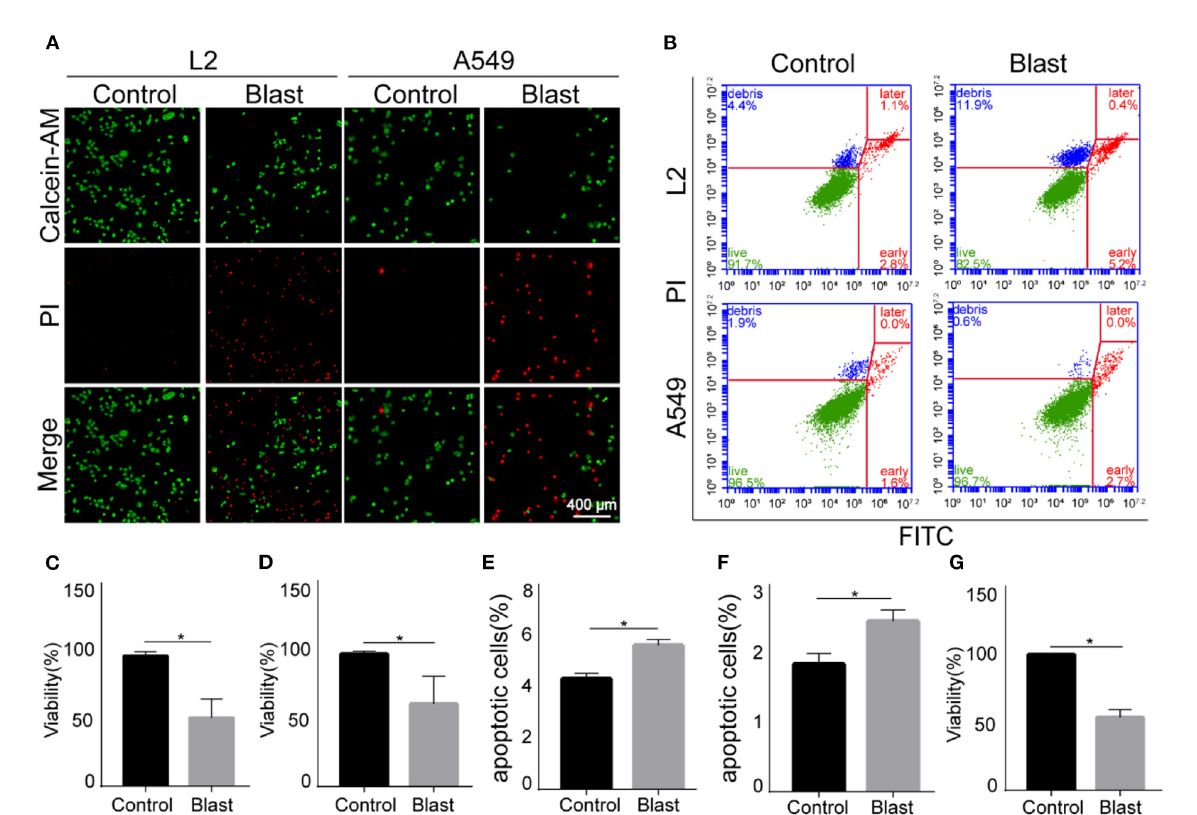
FIGURE4 Effects of blast wave stimulation on viability and apoptosis of L2 and A549 cells. (A) Images of Calcein-AM/PI staining showing the living and membrane-ruptured L2 and A549 cells. Green, living cells; red, membrane-ruptured cells. (B) Dot plot showing the apoptosis of L2 and A549 cells. (C, D) Quantitative analysis and comparison of cell viability between the control and blast wave groups of L2 and A549 cells. (E) Comparison of L2 cell apoptosis between groups. (F) Comparison of A549 cell apoptosis between groups. (G) Comparison of A549 cell viability between groups. Data represent mean ± SD; n = 10. * P < 0.05. FITC, fluorescein isothiocyanate; PI, propidium